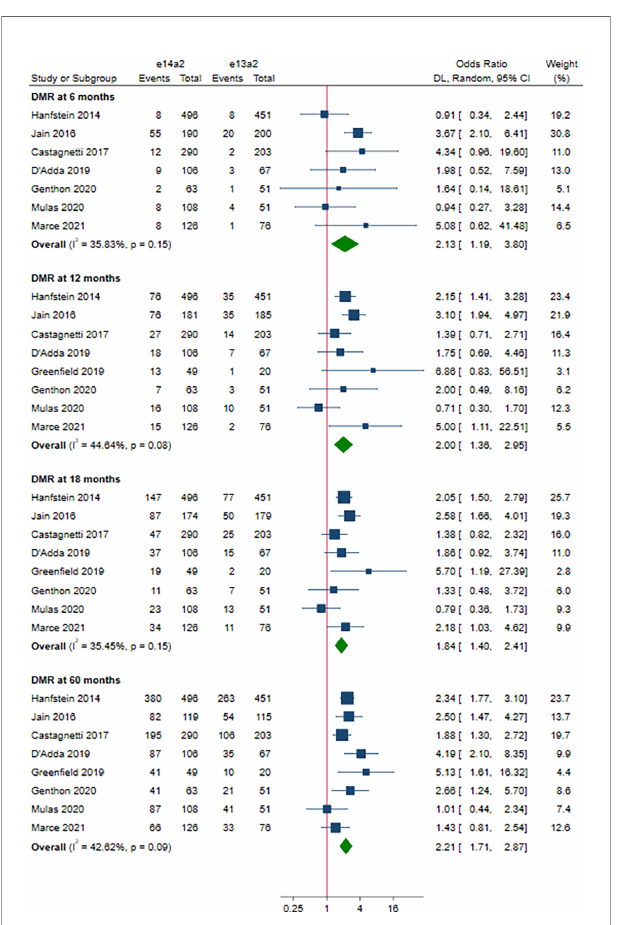
FIGURE 4 | E14a2 versus e13a2: rate of patients who achieved deep molecular response at 6, 12, 18 and 60 months.